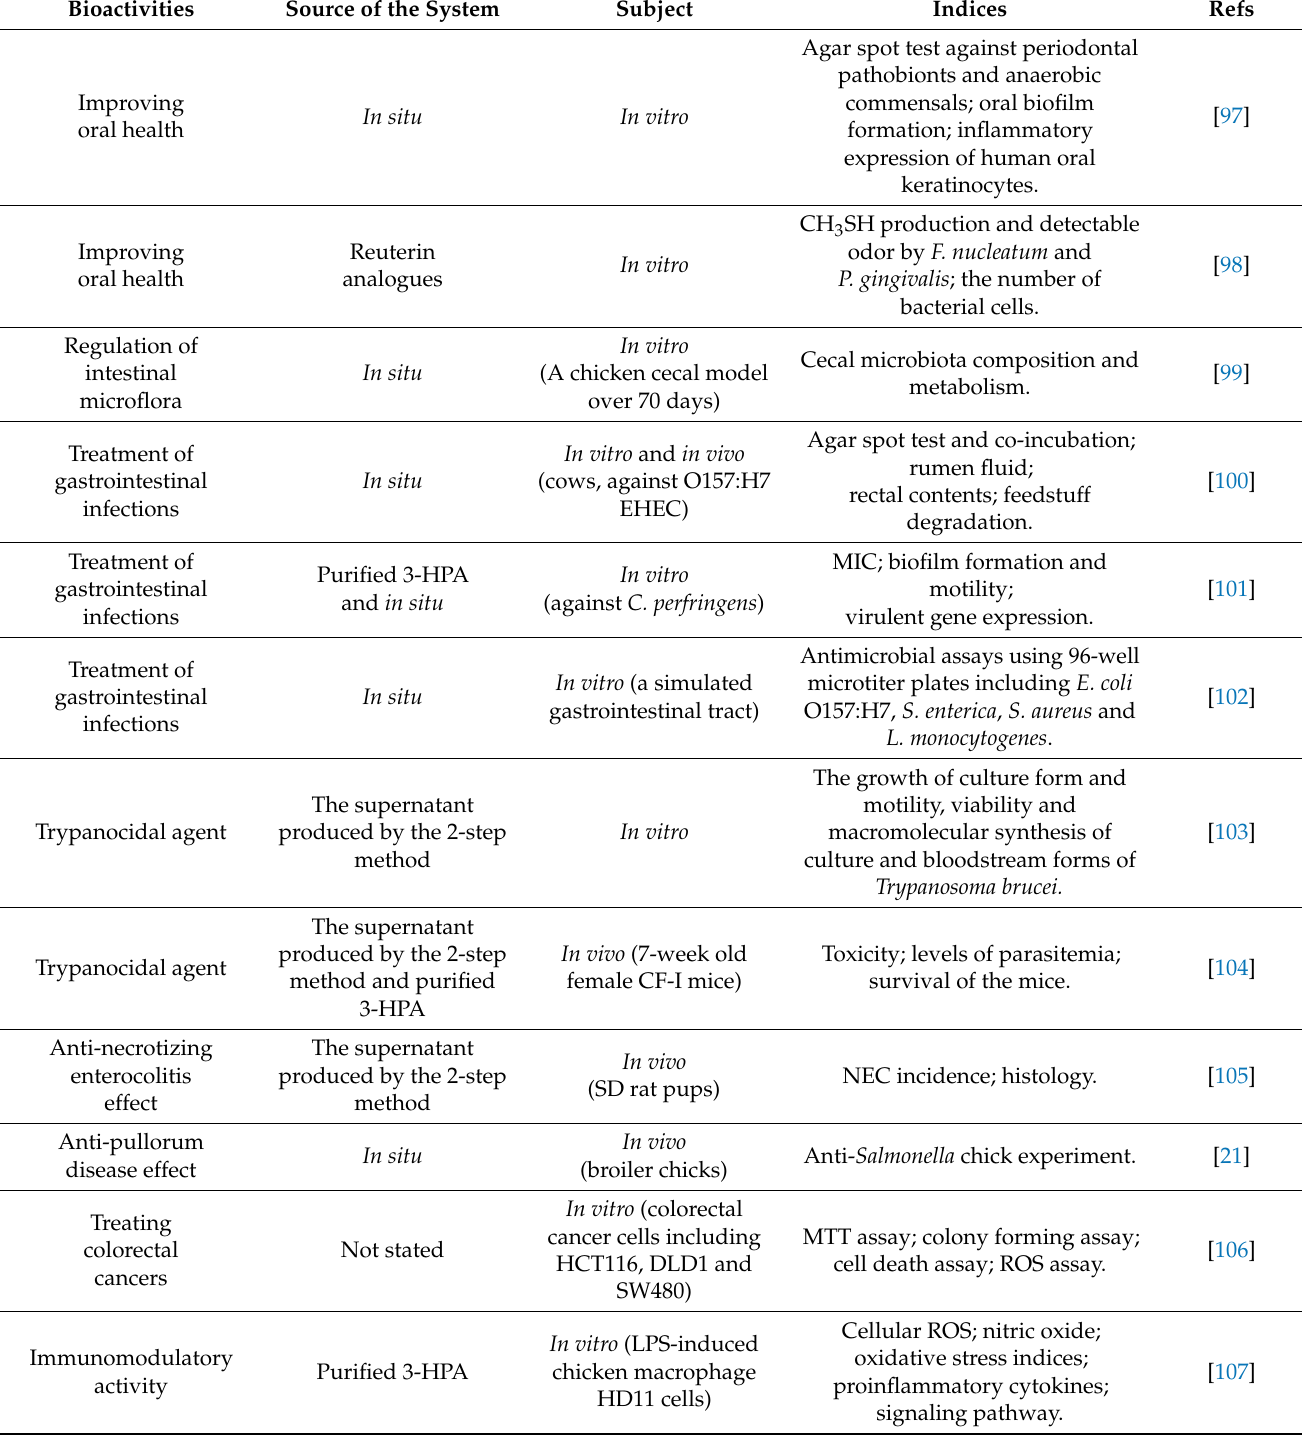
Table 4. The use of the reuterin system as health-promoting